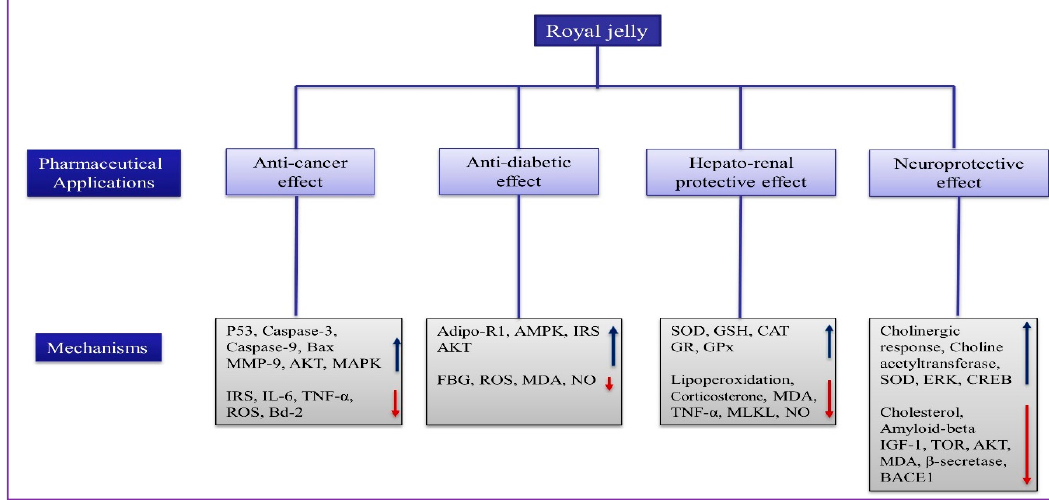
Figure 5. The pharmaceutical effects of RJ and their mechanism. Bax (bcl-2-like protein X); MMP-9 (matrix metallopeptidases-9); AKT (protein kinase B); MAPK (mitogen-activated protein kinase); IRS (insulin receptor substrate 1); IL-4 (interleukin-4); TNF- α (tumor necrosis factor); ROS (reactive oxygen species); AMPK (5 ′ AMP-activated protein kinase); SOD (superoxide dismutase); GSH (glutathione); CAT (catalase); GR(Glutathione reductase); GPx (glutathione peroxidase); MDA (malondialdehyde); NO (nitric oxide); MAKL (mixed lineage kinase domain-like); ERK (extracellular signal-regulated kinases); CREB (cAMP Response Element-Binding Protein); IGF-1 (insulin-like growth factor-1); TOR (target of rapamycin), and BACE1 ( β -site amyloid precursor protein cleaving enzymes).